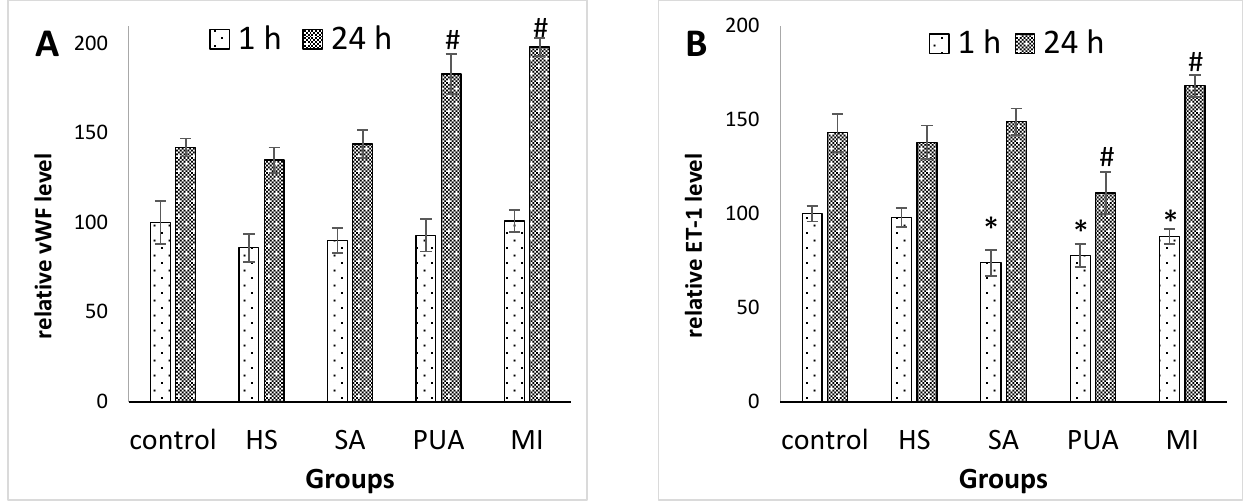
Figure 2. The relative levels of vWF ( A ) and ET-1 ( B ) detected in HEPC culture incubated with peptide fraction isolated from plasma of either healthy subjects (HS), patients with stable angina (SA), progressive unstable angina (PUA), or myocardial infarction (MI). The levels of both vWF and ET-1 in culture treated with buffer instead of peptide solution (control) after 1 h incubation period were set at 100%, and all data shown represent percentage relative to control at 1 h time point. * p < 0.05 compared with control at time point 1 h; # p < 0.05 compared with control at time point 24 h.